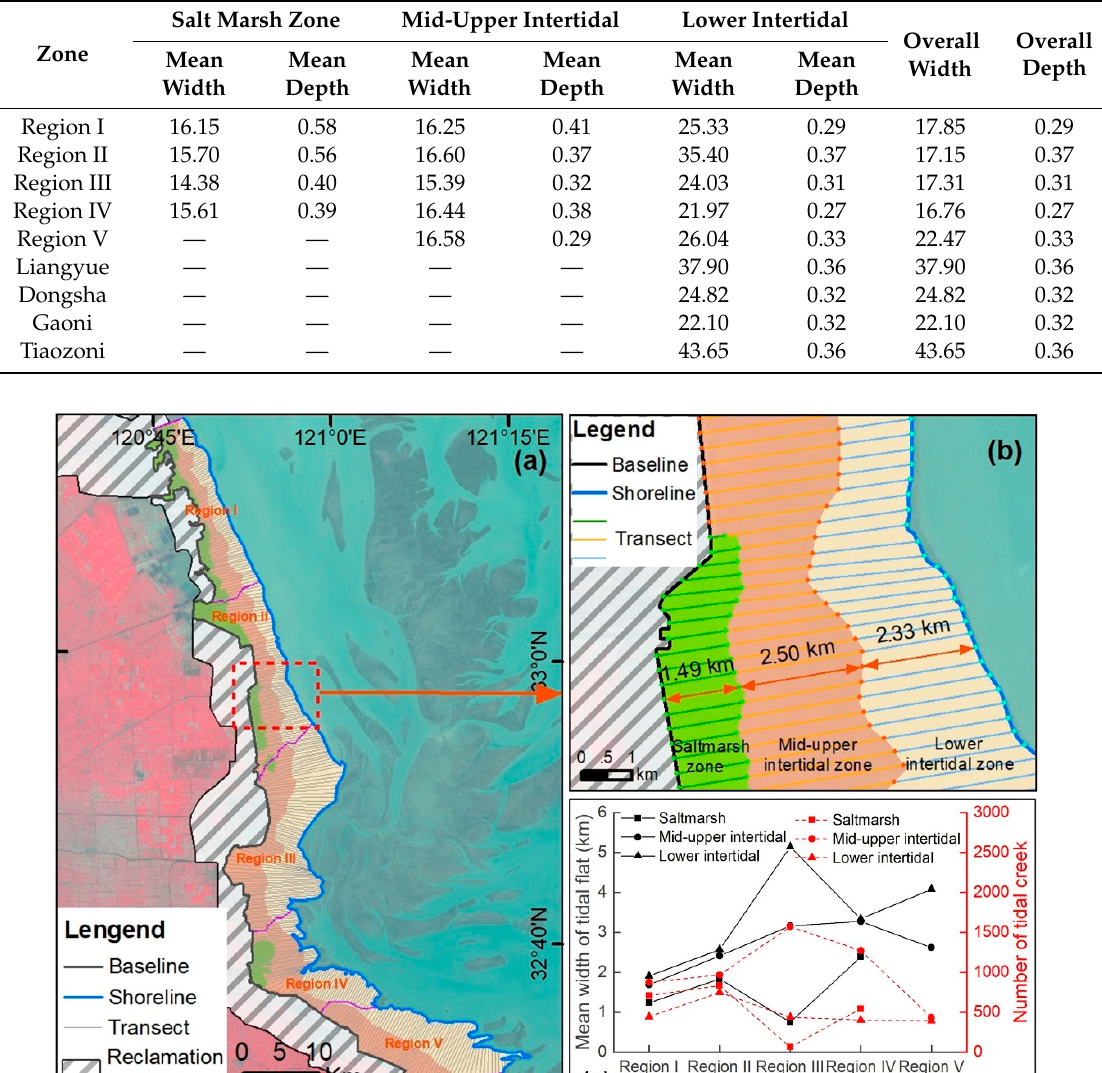
Table 2. Summary statistics of the mean width and depth in di ff erent subzones (unit: m). Salt Marsh Zone Mid-Upper Intertidal Lower Intertidal Zone Zone